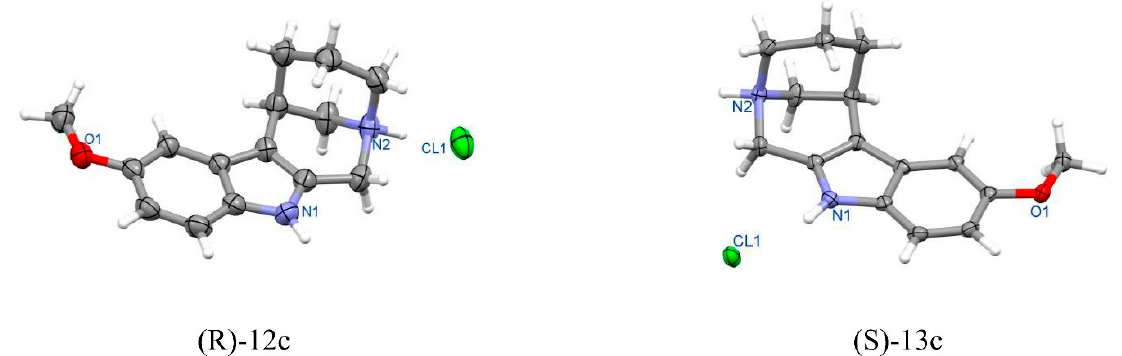
Figure 15. Perspective view of enantiomeric tetracyclic molecules (R)-12c and (S)-13c